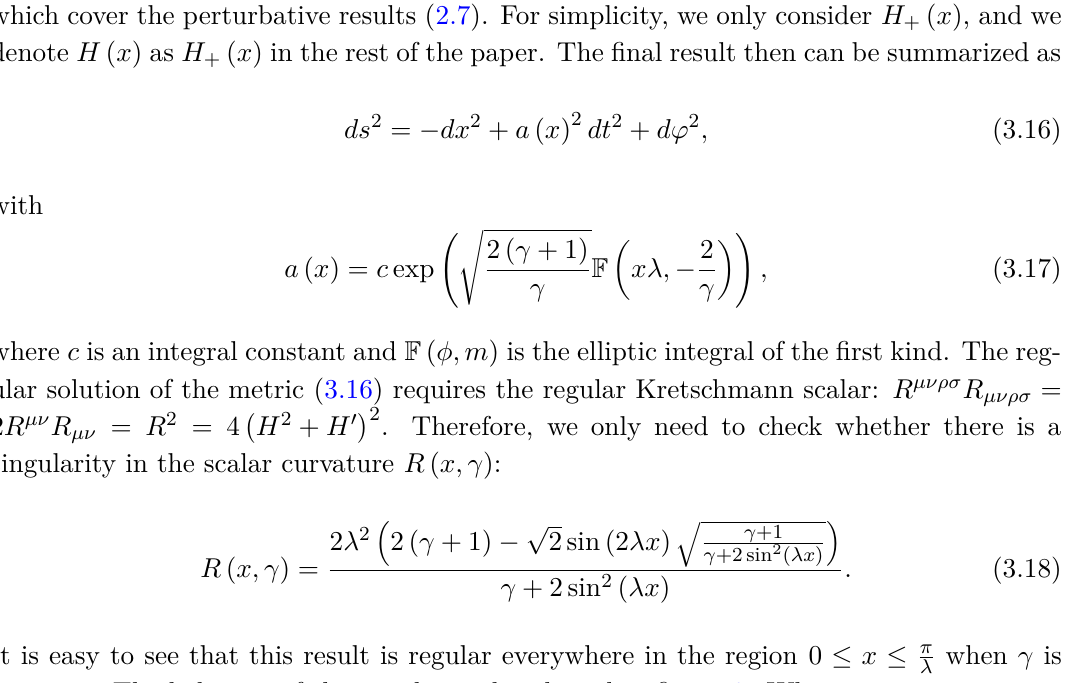
Figure 3 . The behavior of scalar curvature R ( x, γ ) , where λ = 4 and 0 ≤ x ≤ π red line describes the scalar curvature R 0 ( x ) of the perturbative solution